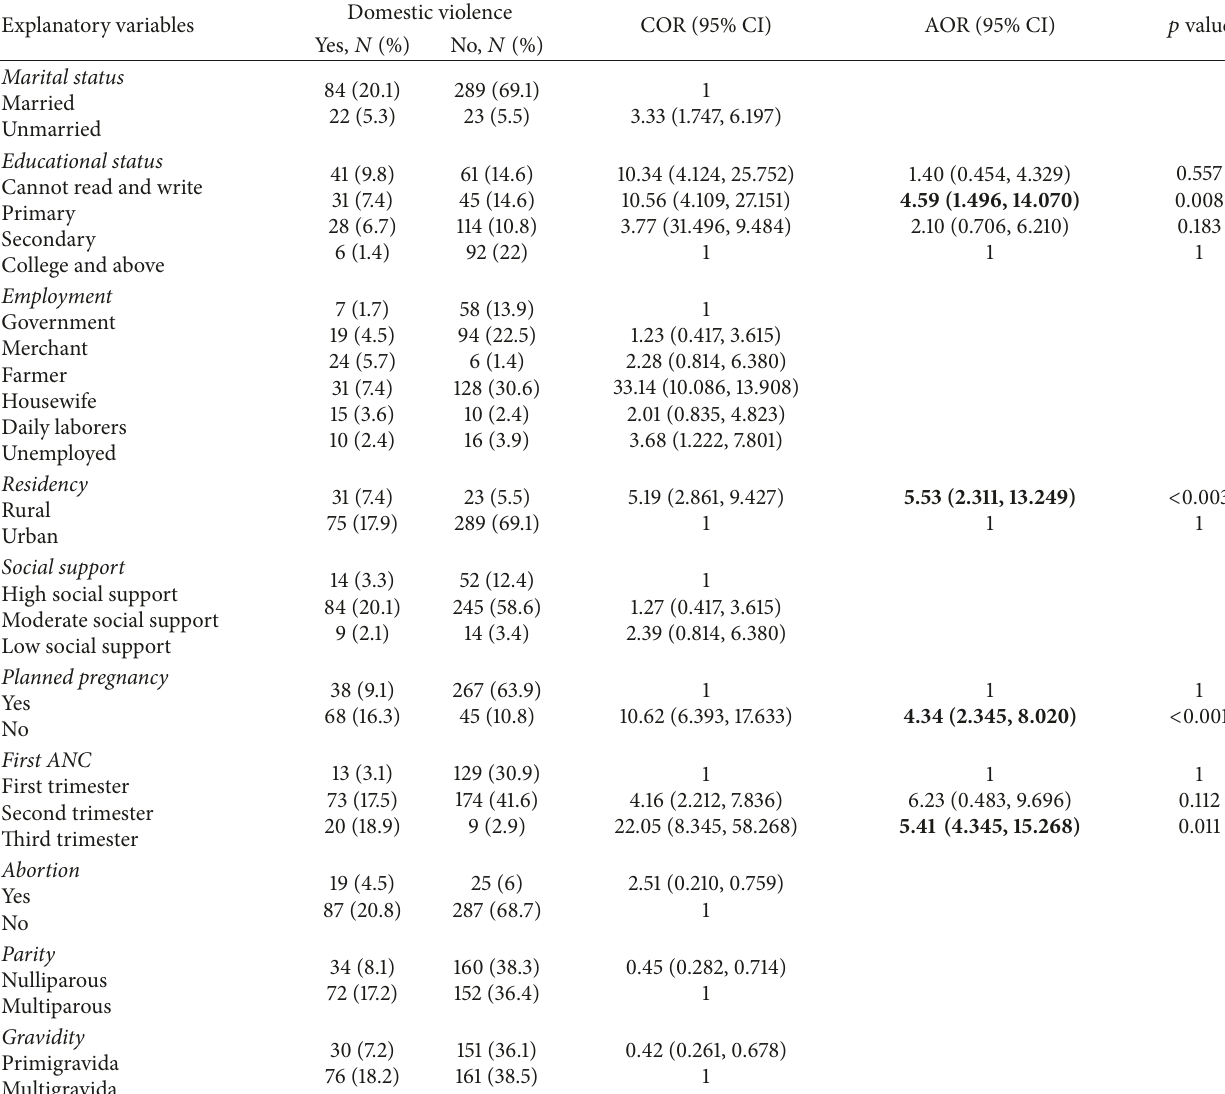
Table 4: Factors associated with domestic violence (bivariate and multivariable) analysis in Gondar town, 2015 (𝑛 = 418) . Explanatory